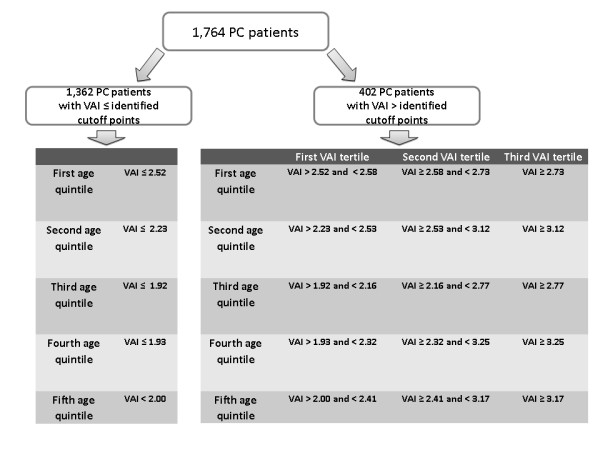
Subdivision of 1,764 PC patients according to identified cut-off points of VAI and age quintiles.